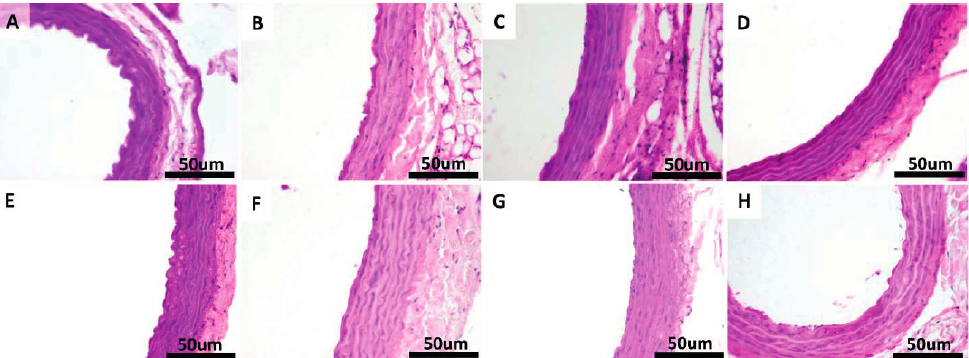
Figure 9. Transverse sections of the aorta stained with Periodic acid-Schiff (PAS) method in: CS group: non-diabetic sedentary untreated control rats ( A ); CE group: non-diabetic trained untreated control rats ( B ); CSQ group: non-diabetic sedentary control rats treated with quercetin ( C ); CEQ group: non-diabetic trained control rats treated with quercetin ( D ); DS group: diabetic sedentary control rats ( E ); DE group: diabetic trained untreated control rats ( F ) and DSQ group: diabetic sedentary rats treated with quercetin ( G ); DEQ group; diabetic trained rats treated with quercetin ( H ). PAS stain, original magnification of